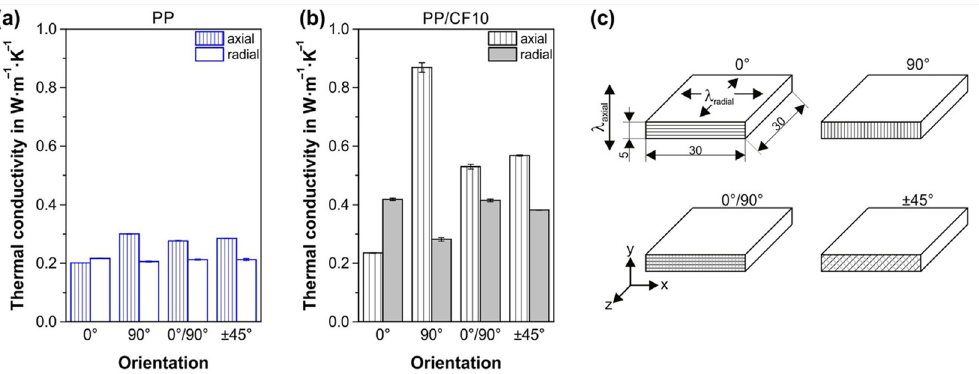
Figure 6. Thermal conductivity measurements based on the printing orientation for ( a ) PP and ( b )PP/CF10. ( c ) shows the corresponding specimen dimensions and build orientations. The layers of printing are stacked in the z-direction and the heat conductivity in the axial direction ( λ axial ) is measured in the y-direction. The heat conductivity in the radial direction ( λ radial ) is also measured in the xz-plane ( c ). Adapted with permission from Ref. [74]. 2018, Elsevier.